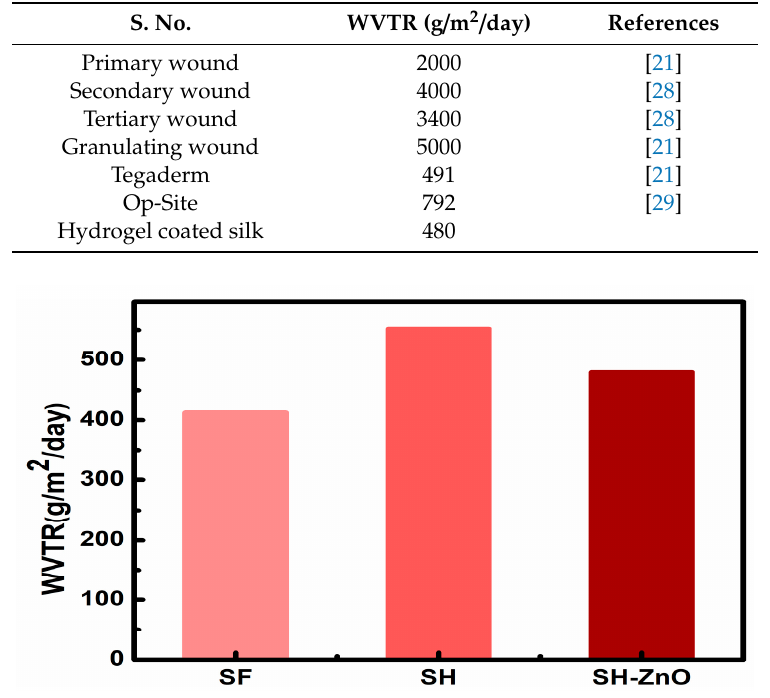
Figure 6. WVTR of di ff erent silk